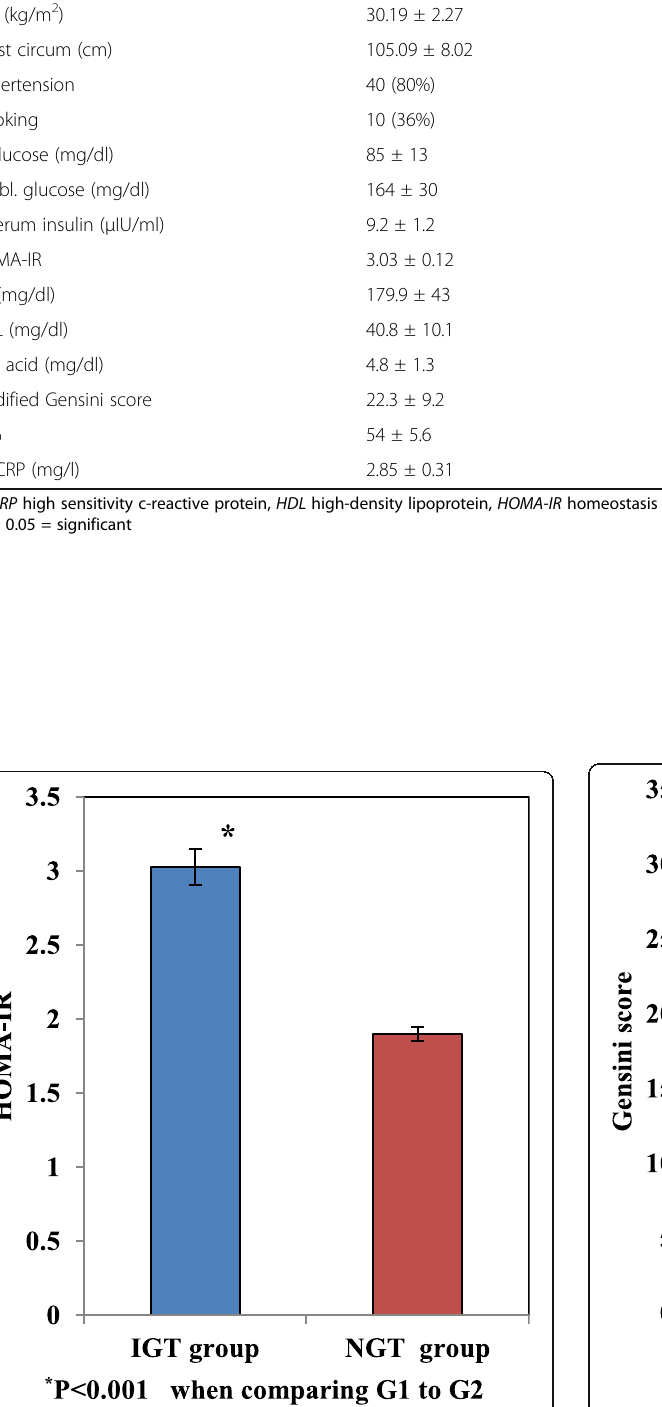
Fig. 1 HOMA-IR of study groups * P < 0.001 when comparing G1 to G2